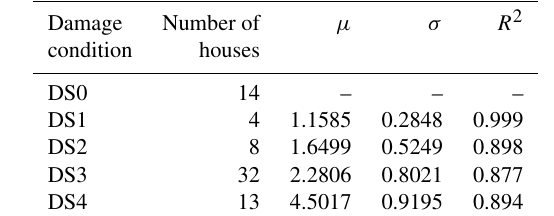
Table 2. A summary of damage conditions of CM-type houses due to impacts of the 2018 Mount Anak Krakatau